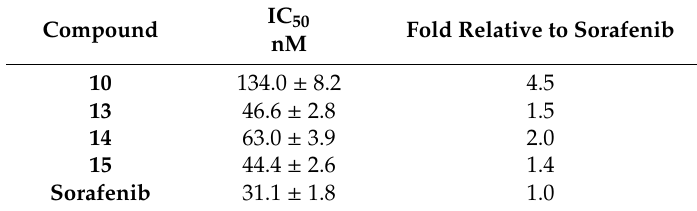
Table 3. E ff ect of compounds 10 , 13 – 15 on VEGFR-2 enzyme and their fold